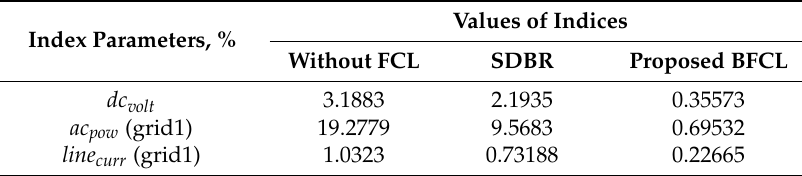
(two grids-connected VSC-HVDC system).